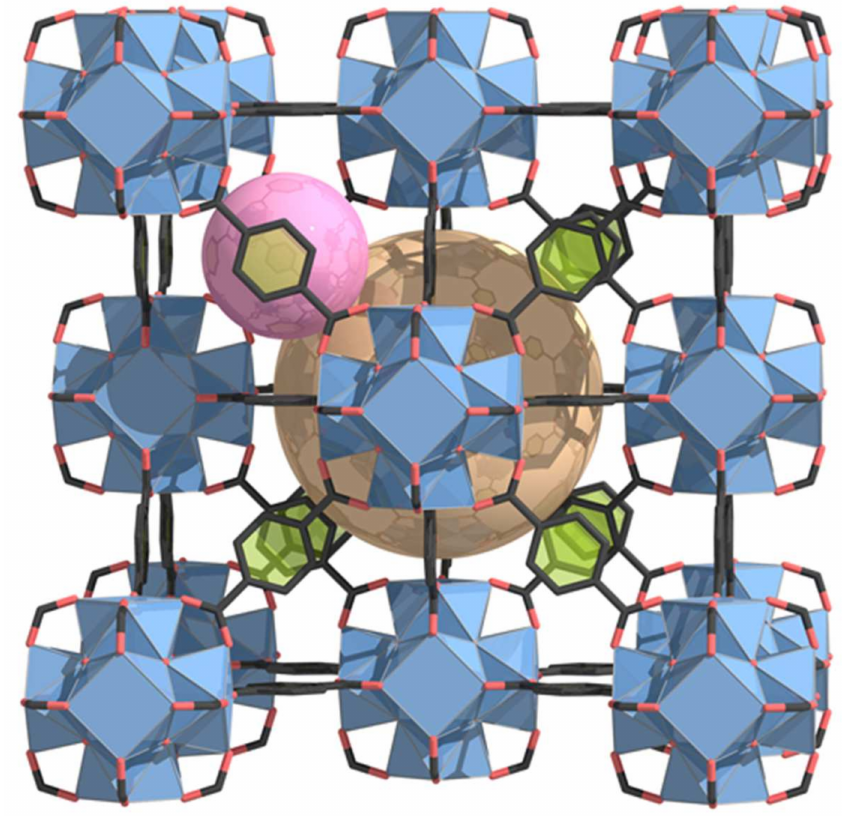
Figure 15. Crystal structure of UiO-66 MOF, where blue polyhedra represent the 12-coordinated Zr-based metal clusters that are interconnected by BDC linkers with fcu topology. (Red: oxygen, and carbon: grey; pink sphere represents the tetrahedral cage and brown sphere represents the octahedral